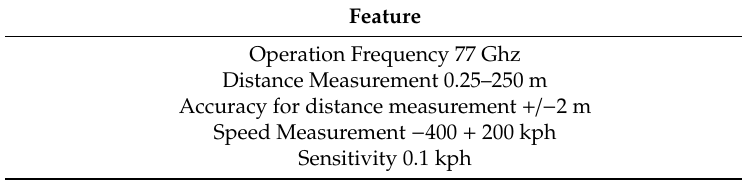
Table 4. RADAR characteristics.